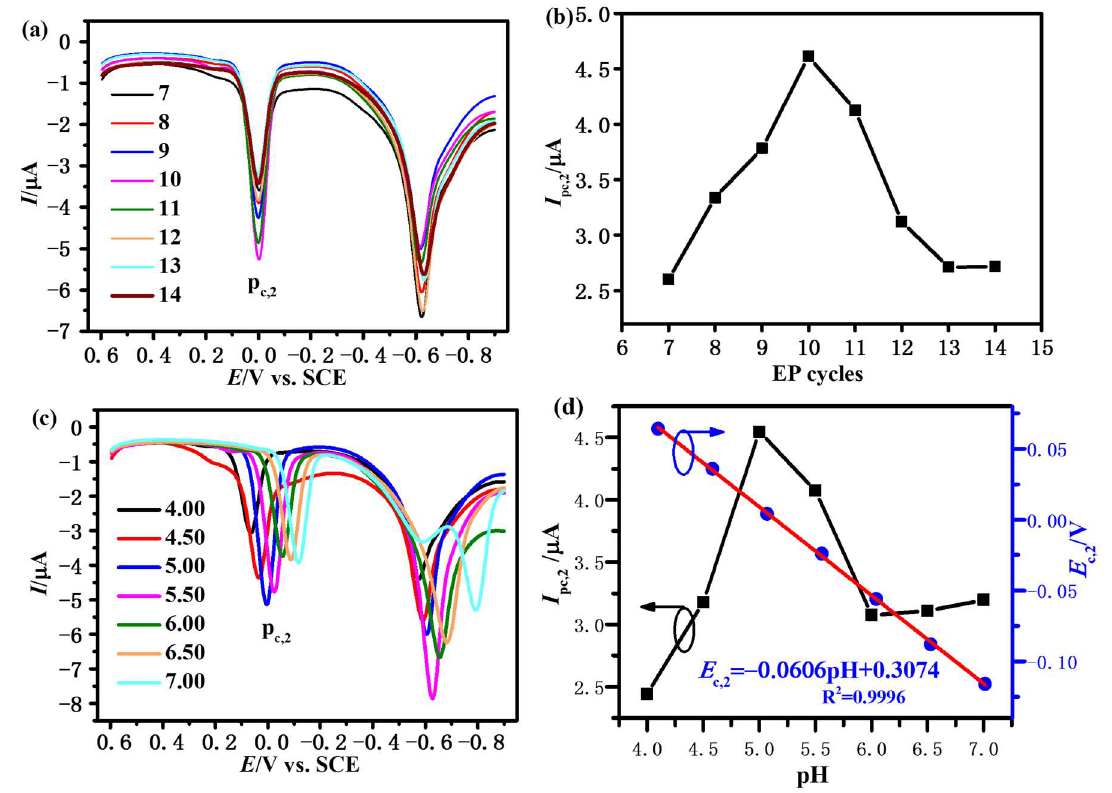
Figure 3. ( a ) The third-step DPV curves of FNT (2 μg/mL in acetate buffer solution, pH = 5.00) on β-CDP/GCE prepared with different EP cycles; ( b ) the variation in I pc,2 with EP cycles; ( c ) the third-step DPV curves of FNT (2 μg/mL in acetate buffer solution with different pH) on β-CDP/GCE; ( d ) the variation in I pc,2 and E c,2 with pH. DPV parameters: potential increment of 13 mV, amplitude of 50 mV, pulse width of 60 ms, sampling width of 20 ms, pulse period of 500 ms, and potential from 0.6 to −0.9 V.